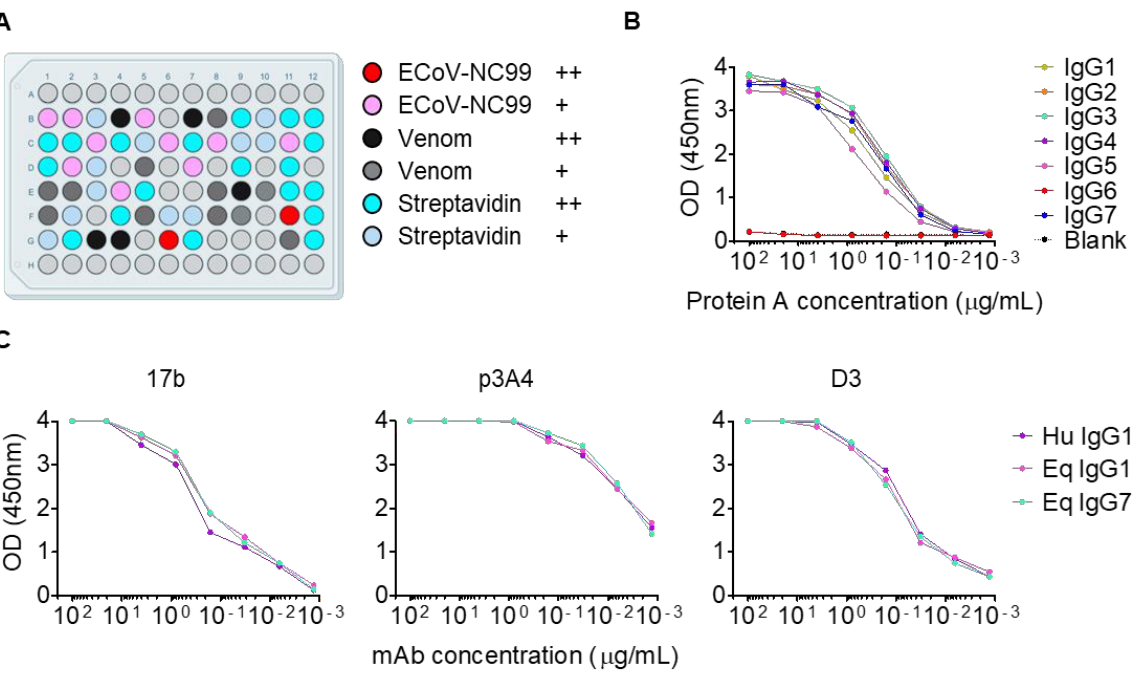
Figure 4. Antigen recognition by human and equine isotypes. ( A ) Single point ELISA plate map of monoclonal antibody cell culture expression supernatants. Absorbance measurements greater than half maximal OD450 nm (++ OD: 4 > 2) for ECoV-NC99, D. polylepis venom, or Streptavidin was coloured red, black, and cyan, respectively, while ELISA positives less than half maximal OD450 nm (+ OD: 2 > 0.5) were coloured pink, grey, and light blue, respectively. ( B ) Titrated ELISA of equine Fc domains bound to protein A. Absorbance (OD450 nm) is shown on the y -axis, and protein A concentration on the x -axis. IgG6 Fc did not bind protein A (red) and overlaps with the blank curve (black). ( C ) ELISA curves for ECoV-NC99 binding antibody 17b, D. polylepis binding antibody p3A4, and streptavidin binding antibody D3 are shown. Absorbance (OD450 nm) is shown on the y -axis, and antibody concentration on the x -axis. Antibodies were cloned into a human IgG1 isotype expression cassette (purple), a horse IgG1 expression cassette (pink), or a horse IgG7 expression cassette (cyan).